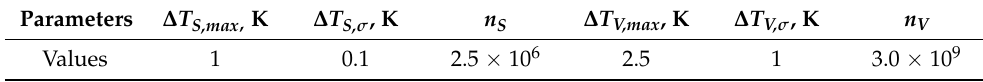
Table 2. Nucleation parameters of CAFE model.